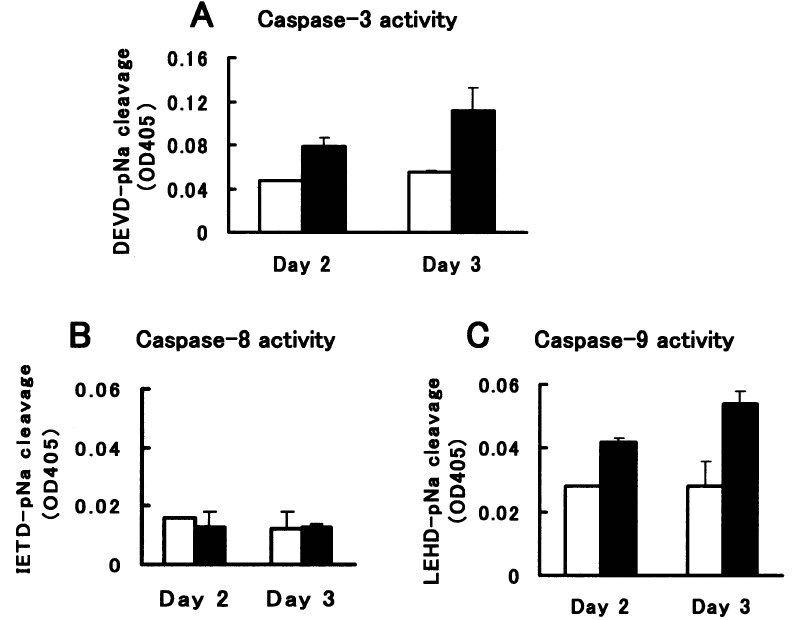
FIG. 5. Caspase-3, caspase-8, or caspase-9 activities of the BAC1.2F5 cells cultured with securioside B. The BAC1.2F5 cells were cultured without (white bars) or with 10 m g/ml securioside B (black bars) in the presence of L-cell-conditioned medium (20%). On the indicated days, the cells were harvested, and caspase-3 activity (A), caspase-8 activity (B), and caspase-9 activity (C) were measured as described in Materials and methods. Bars represent upper and lower values of duplicate